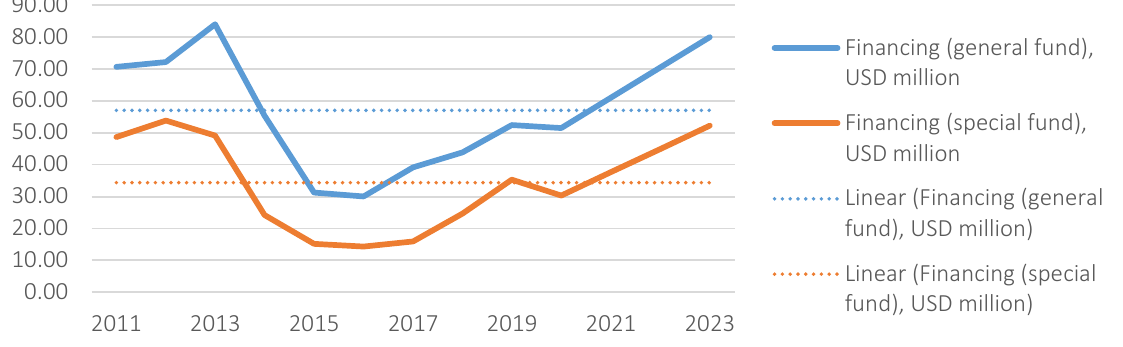
0.0010.0020.00 Figure 3. Dynamics (2011–2020) and short-term forecast (2021–2023) of the amount of the University’s funding under the general and special fund, USD mln